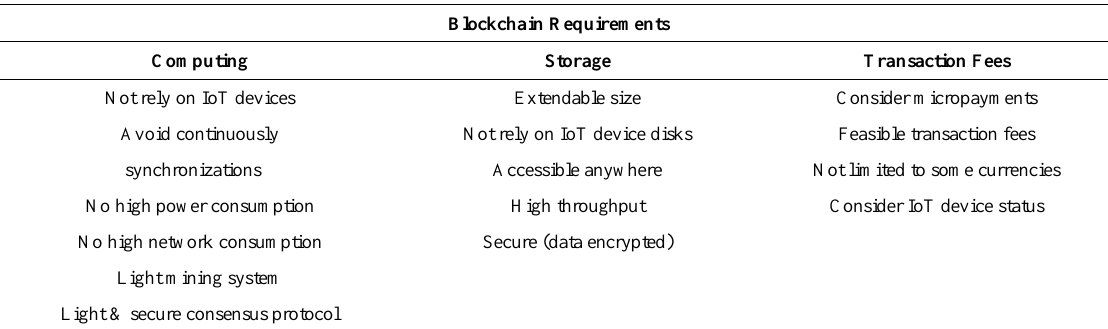
Table 2. Ideal Blockchain requirements for the supply